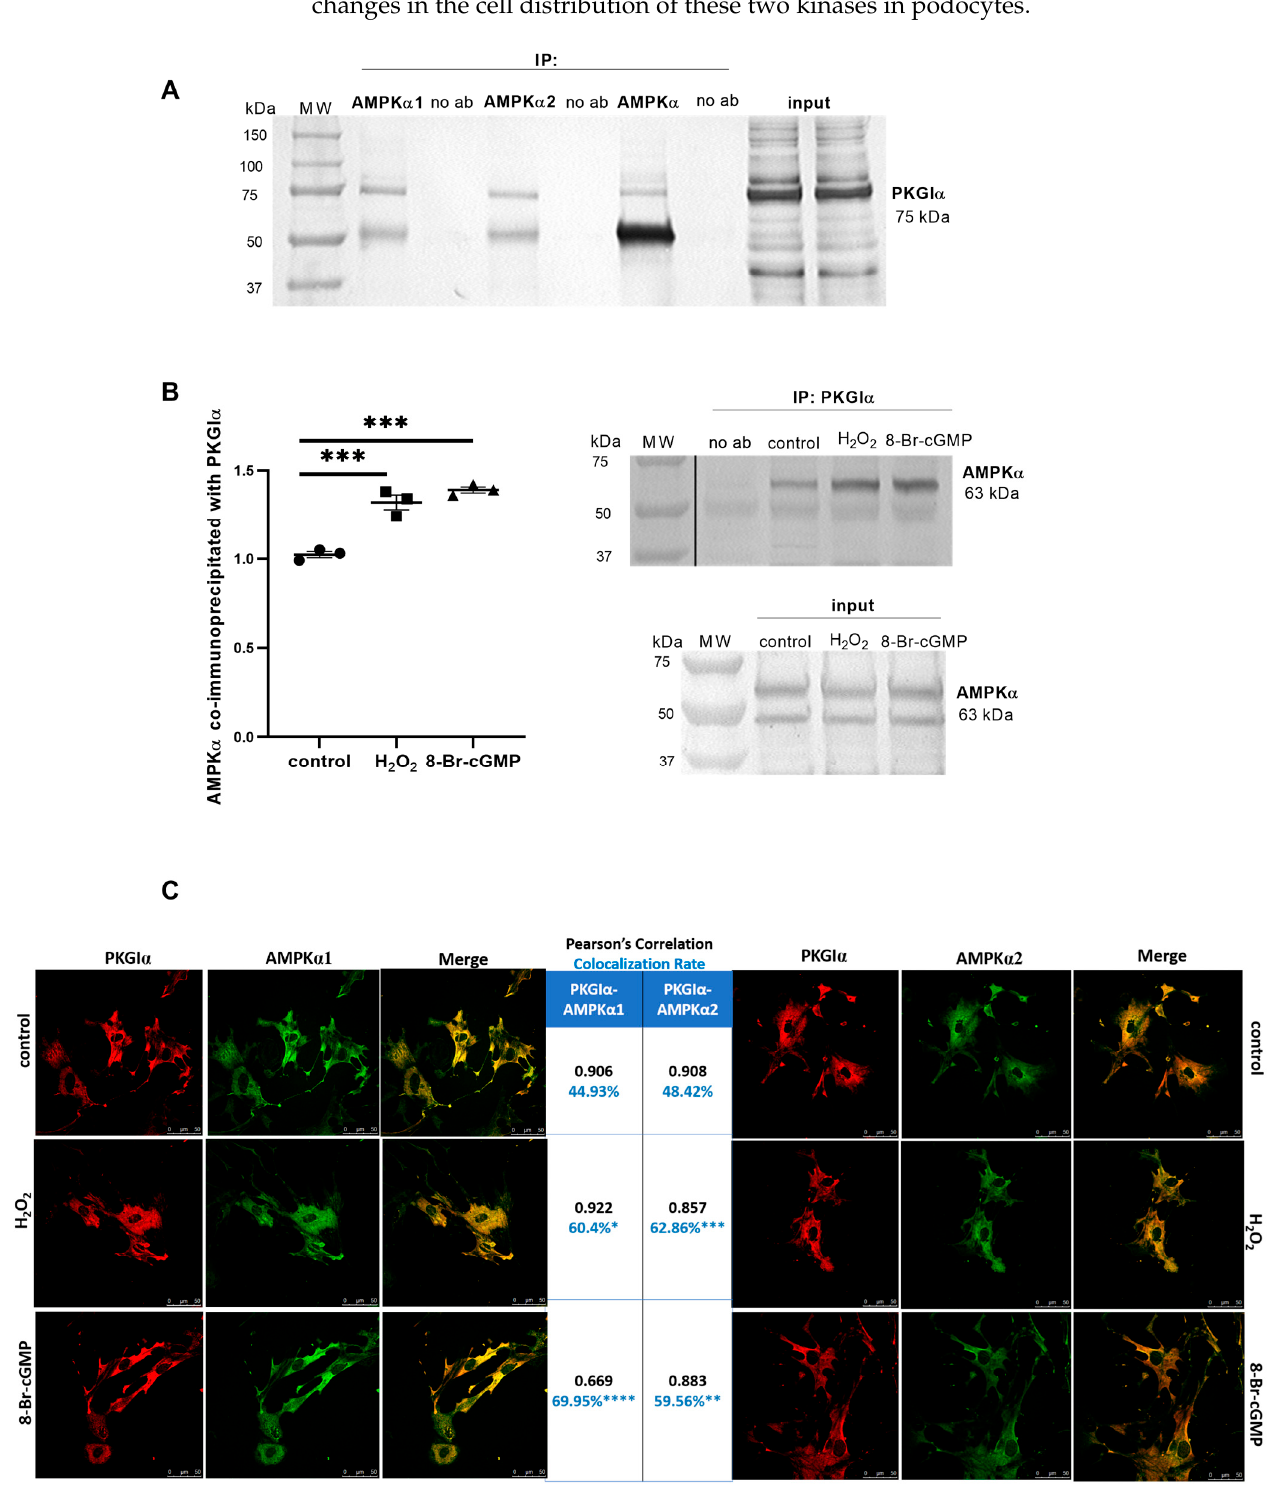
Figure 4. PKGI α and AMPK α form a complex in cultured rat podocytes. ( A ) Immunoblots that show that PKGI α is associated with immunoprecipitated AMPK α 1 and AMPK α 2 subunits in podocyte extracts; ( B ) Densitometry analysis of coimmunoprecipitation immunoblots comparing coimmunoprecipitated protein to total protein (input). H 2 O 2 and 8-Br-cGMP (100 μ M, 5 min) increased the amount of AMPK α that co-immunoprecipitated with PKGI α ( n = 3, *** p < 0.001, Dunnett’s test). Right panel: representative co-immunoprecipitation immunoblots; ( C ) Podocytes were seeded on coverslips, treated with H 2 O 2 or 8-Br-cGMP (100 μ M, 5 min), and then incubated with anti-PKGI α and anti-AMPK α 1 or anti-AMPK α 2 antibodies as indicated. Pixel intensities were